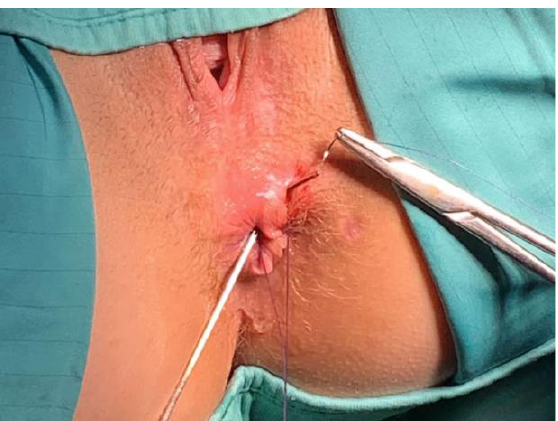
Figure 2. Following an accurate curettage of the AF with a brush and Volkmann spoon removing both the intraluminal epithelium and granulation tissue, the fistula tract was cannulated with a fistula probe and prepared for the implant of the hAM.